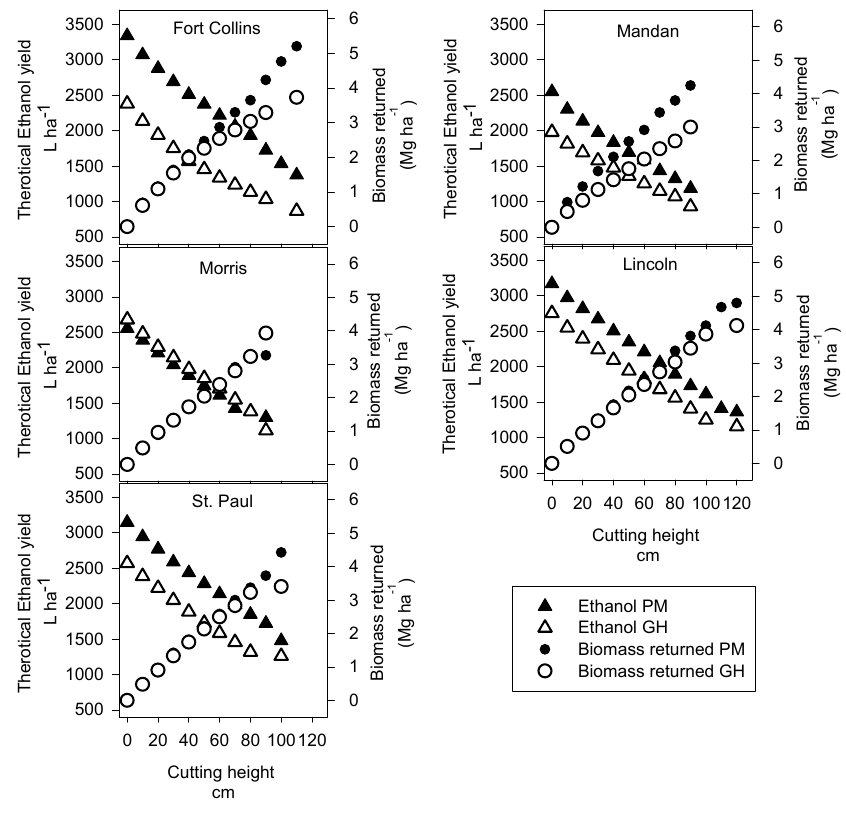
Figure 2. For illustrative proposes, theoretical yield (L·ha − 1 ) at five locations biomass harvested assuming different cutting heights and the corresponding biomass retained in the field reported by Wilhelm et al. [16], excluding cob mass. Maximum cutting height varies among location based on average ear height at physiological maturity (PM) or grain harvest (GH) reported by Johnson et al.